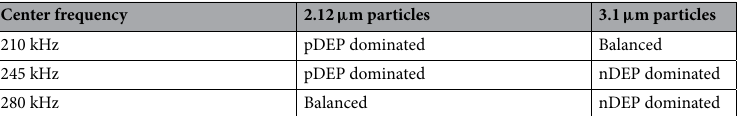
Table 1. Anticipated particle behaviour in the DPC experiments based on their crossover frequency. The 2.12 µ m particles show their crossover at 290 kHz and the 3.1 µ m particles at 210 kHz.